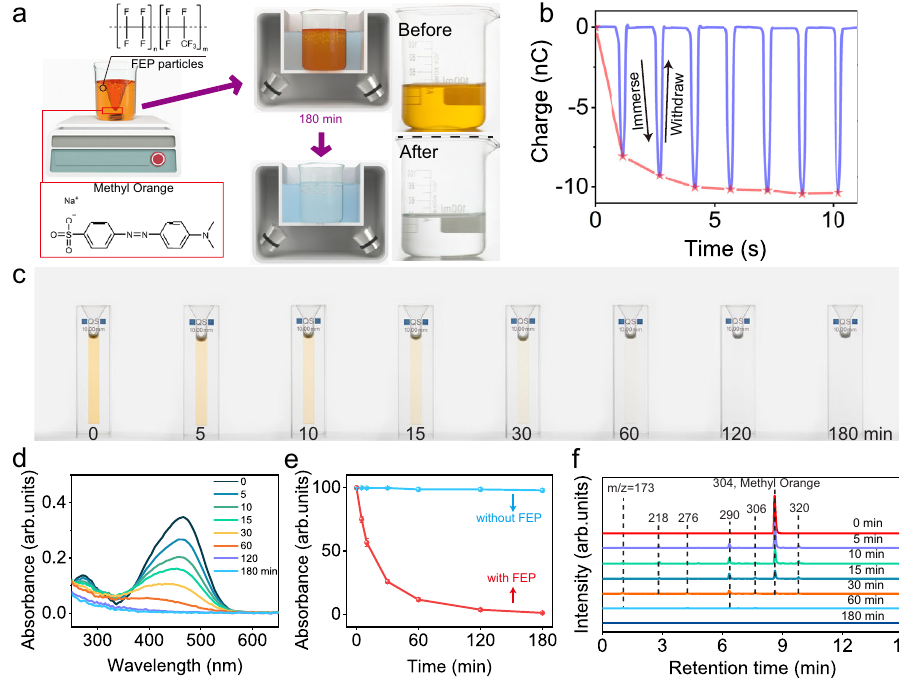
Fig. 1 Degradation of methyl orange by contact-electro-catalysis. a 3D schematic of the experimental setup and protocol. b Measured electric output of a single electrode TENG that is repeatedly immersed in DI water. c Photographs of MO aqueous solution samples from 0 to 180 min. d UV-Vis spectra of a 50 mL aqueous methyl orange (MO) solution during ultrasonication in presence of FEP powder (20 mg) for 3 h. e Comparison of absorbance of MO solution between situations of with/without FEP powder. f Mass spectra of the MO solution after separation by liquid-chromatography. Error bars represent standard deviation based on three replicate